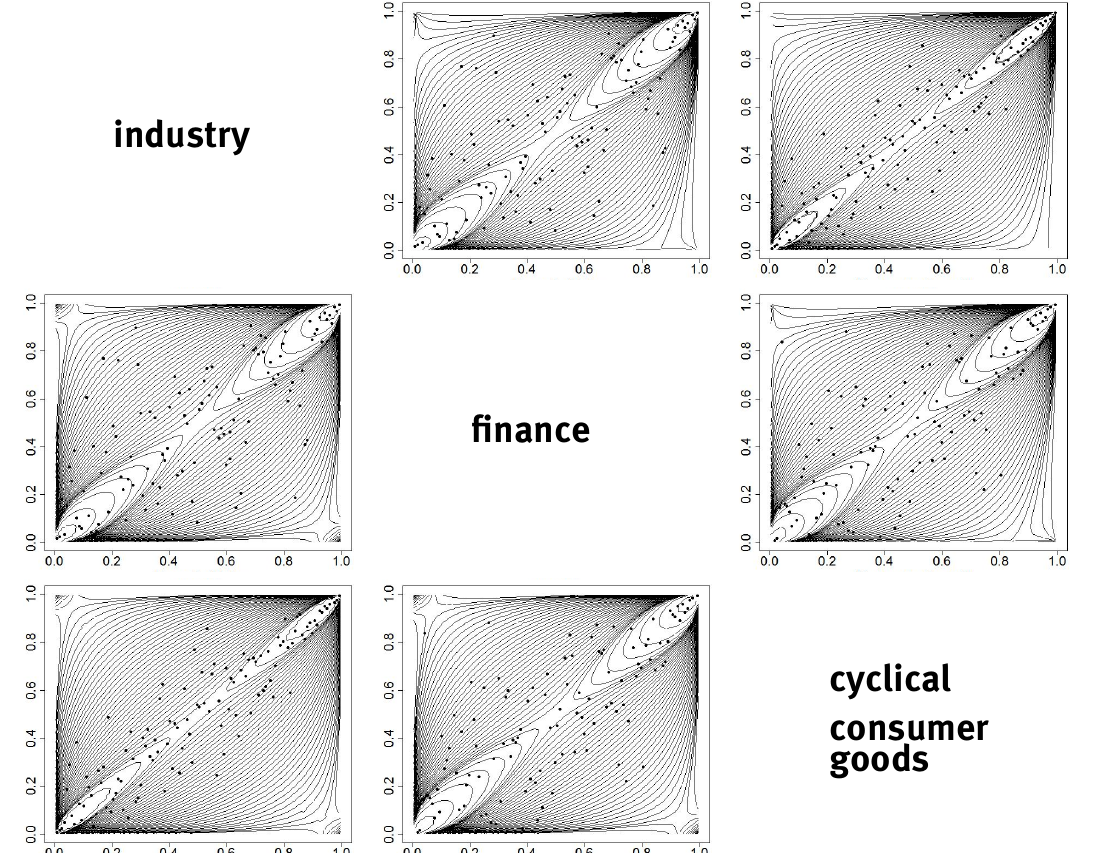
Fig. 4. Symmetric (lower triangle matrix) and asymmetric ghyp copula (upper triangle matrix) together with empirical observa- tions.